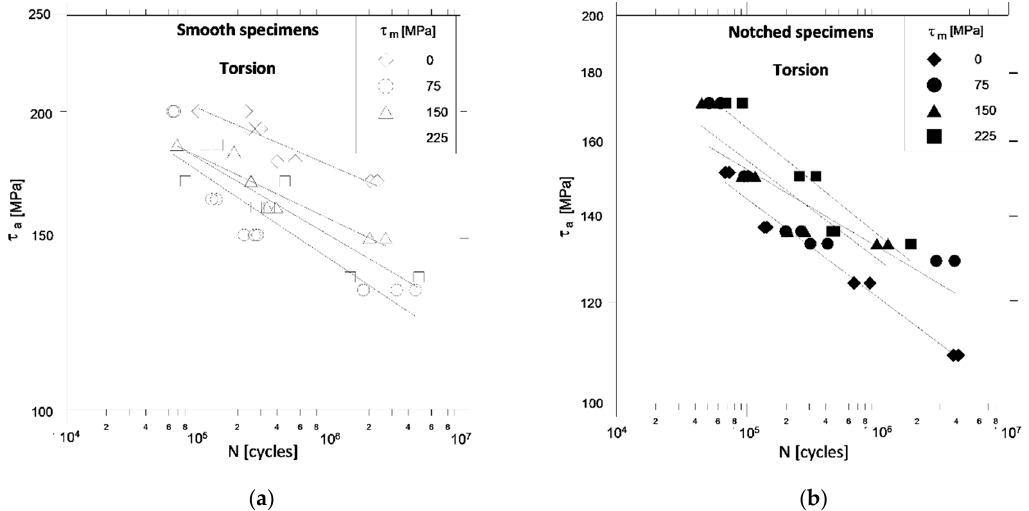
Figure 4. Comparison of fatigue characteristics of smooth ( a ) and notched ( b ) specimens under torsion and different values of mean stress.